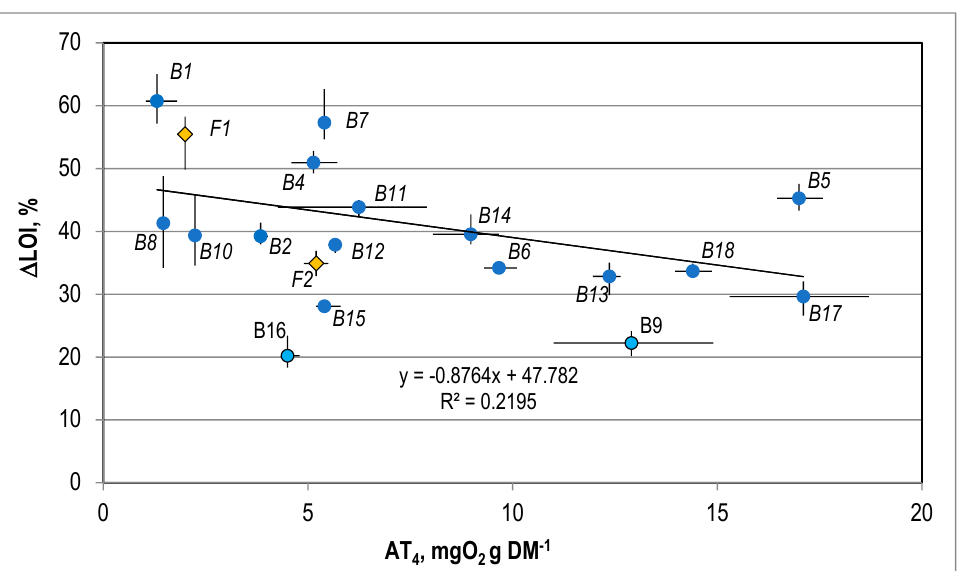
Figure 4. The correlation between AT4 and biogas potential (GB21) for the stabilized waste.